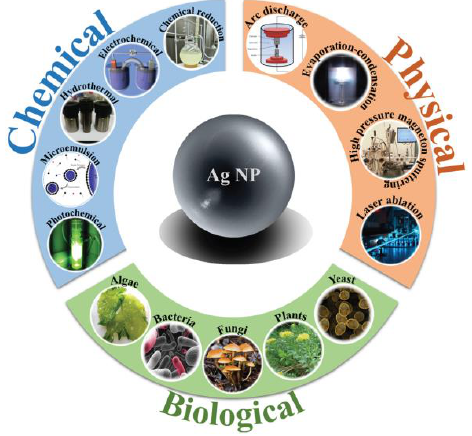
Figure 1. Schematic representation of some of the main methods available for the synthesis of silver nanoparticles (AgNPs). Reprinted from [61], with permission from Elsevier.